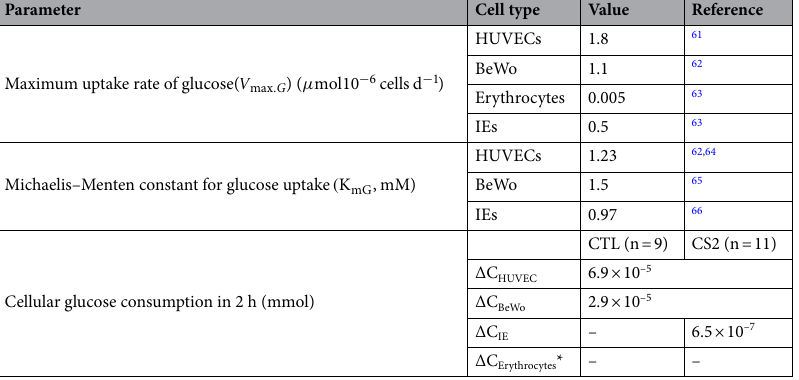
Table 1. Glucose consumption parameters and values. *Erythrocyte glucose uptake rate is two orders of magnitude lower than IEs. The cellular consumption was therefore neglected in the